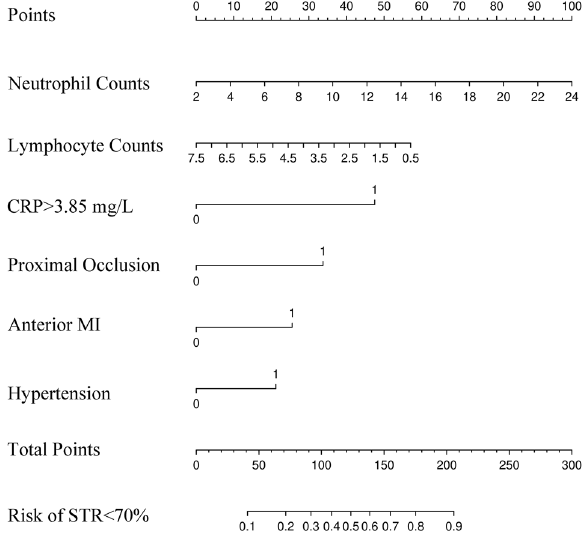
Figure 5. Nomogram model predicting STR < 70% after primary PCI.